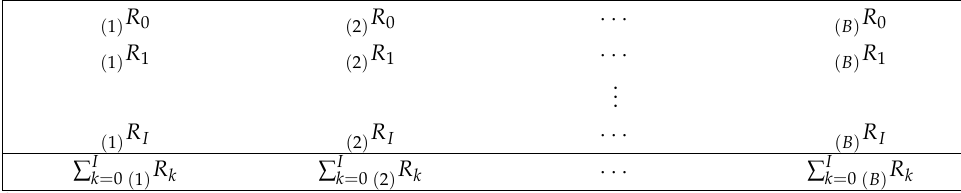
Table 4. Simulated reserves columns and their sums.